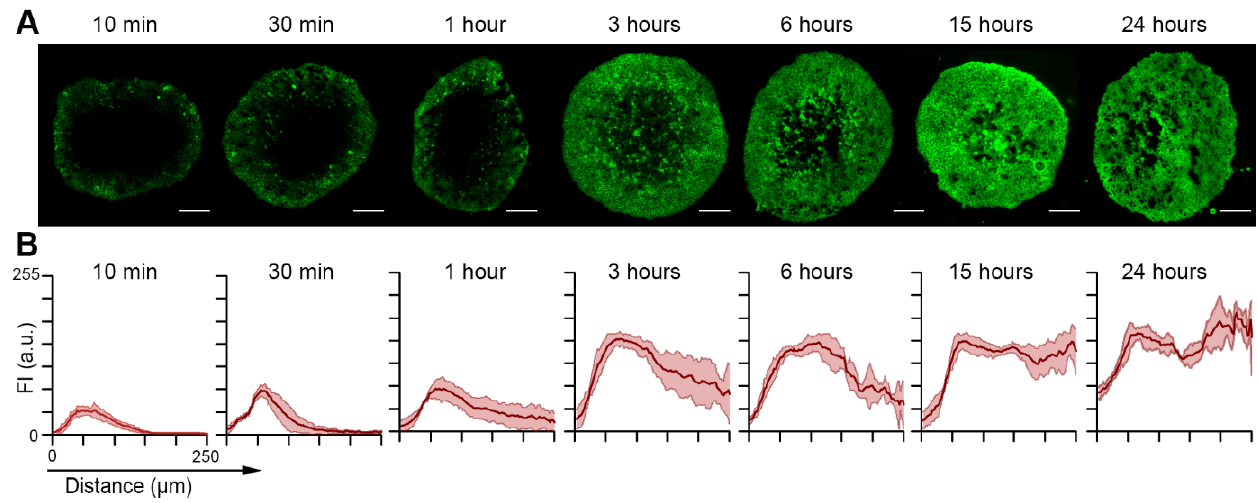
Figure 3. Distribution of ICG in FaDu spheroids after different incubation times. ( A ) Typical fluorescence images of ICG fluorescence in FaDu spheroids after different incubation times with 0.05 mg/mL of ICG. All scales bars represent 100 µ m. ( B ) Penetration profiles of ICG in FaDu spheroids after the same incubation time. ICG concentration was 0.05 mg/mL. The data are presented as mean ± SD obtained from n = 4 spheroids.